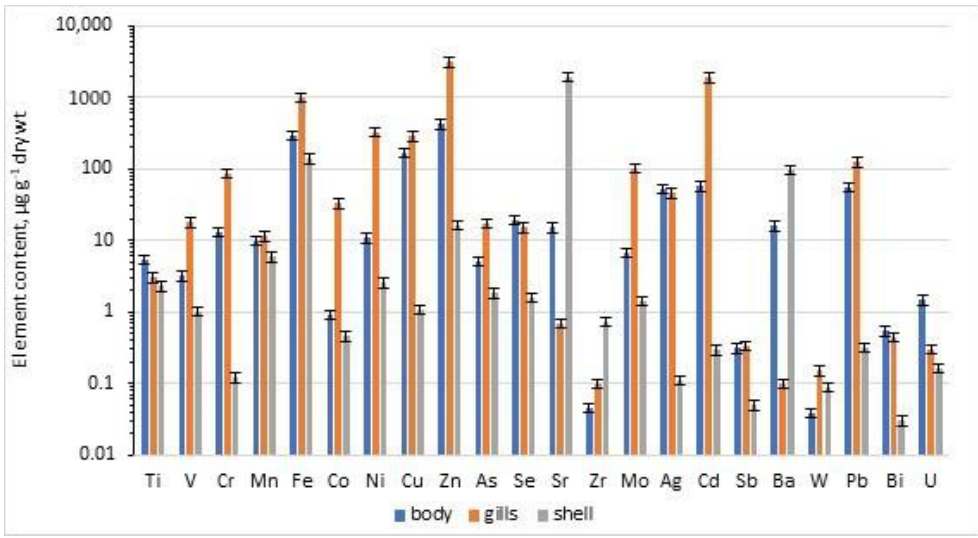
Figure 3. Partitioning of the average element concentrations in the body parts of C. pacifica inhabiting the southern summit of the Piip Volcano.